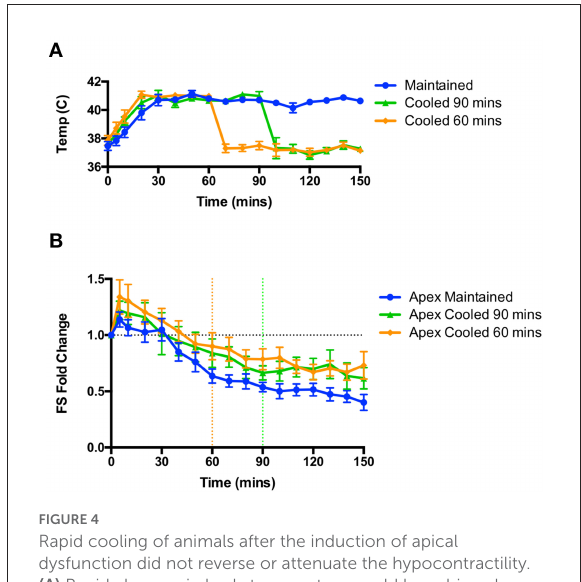
FIGURE4 Rapid cooling of animals after the induction of apical dysfunction did not reverse or attenuate the hypocontractility. (A) Rapid changes in body temperature could be achieved through the application of cooling. (B) No effect of cooling was observed on apical dysfunction on rats cooled at 60min (from orange dotted line) or 90min (from green dotted line); n = 6 animals per group. Repeated measures ANOVA.